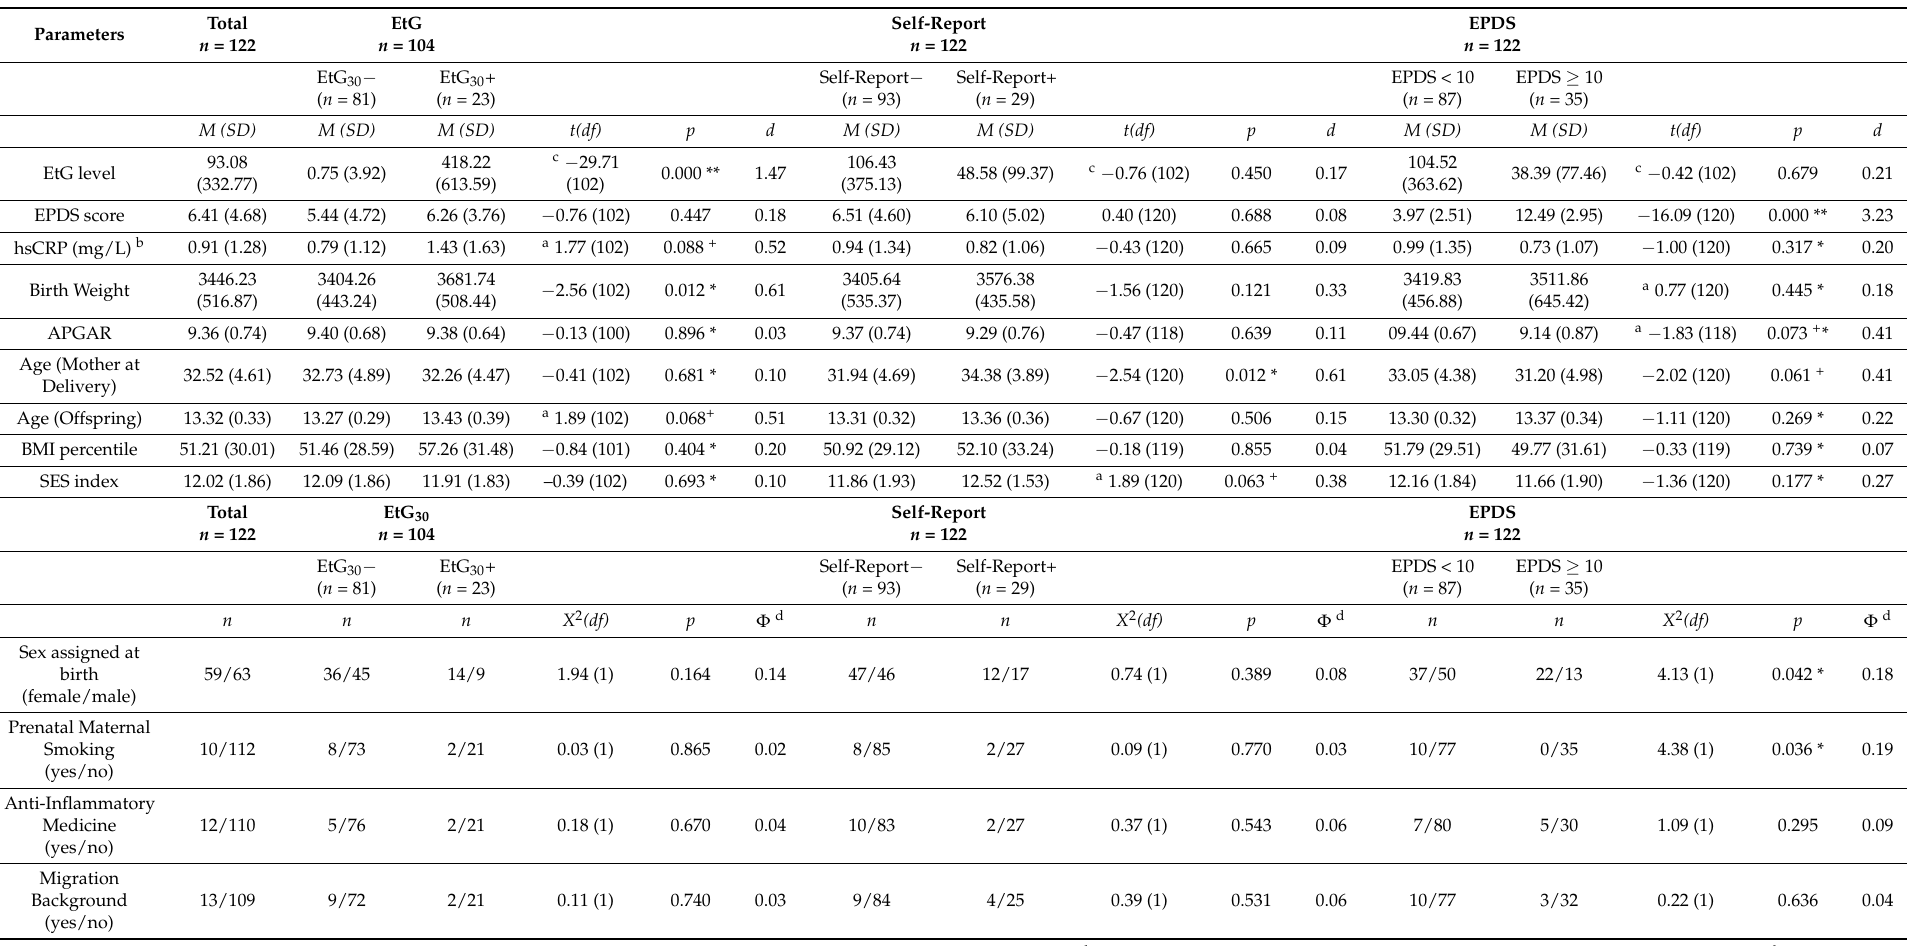
Table 1. Sample Characteristics and Mean/Frequency